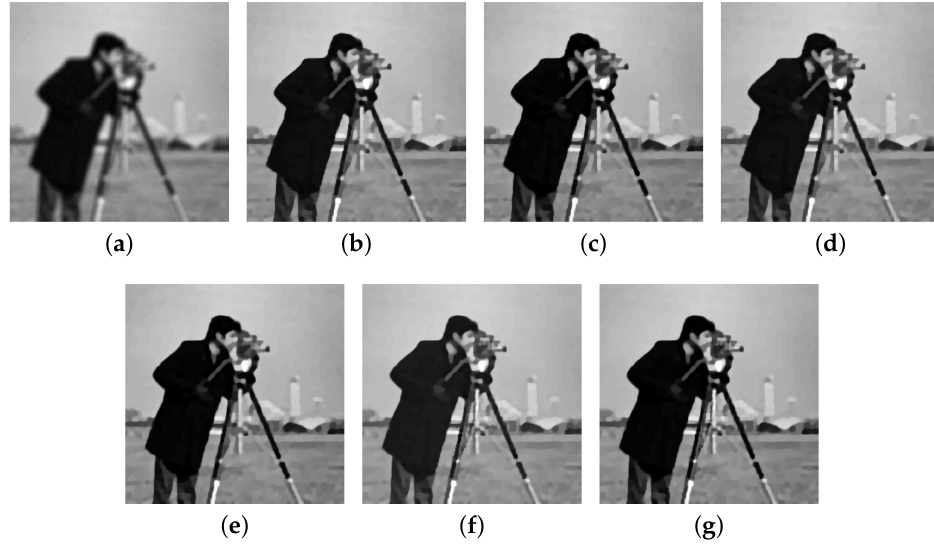
Figure 8. Reconstruction from blurry and noisy data. ( a ) Blurry and noisy observation; ( b ) pAPS with pdN with η = 0 (PSNR: 24.281; MSSIM: 0.34554); ( c ) pAPS with box-constrained pdN (PSNR: 24.293; MSSIM: 0.34618); ( d ) ADMM (PSNR: 24.236; MSSIM: 0.34073); ( e ) Box-constrained ADMM (PSNR: 24.237; MSSIM: 0.34082); ( f ) pLATV with pdN with η = 0 (PSNR: 24.599; MSSIM: 0.34708); ( g ) pLATV with box-constrained pdN (PSNR: 24.622; MSSIM: 0.34769).